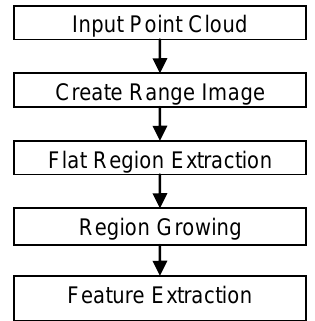
Figure 2. Flowchart of the Segmentation process.